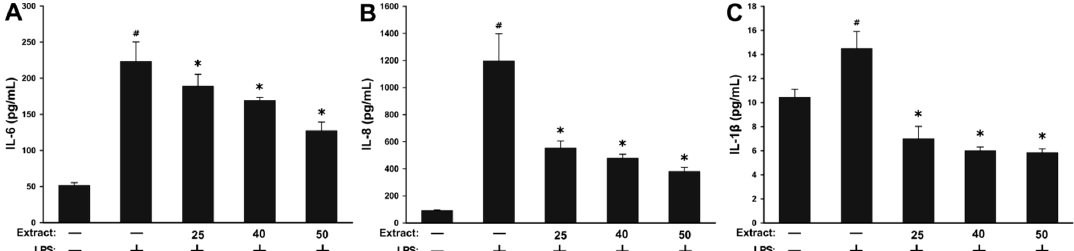
Figure 4. The extracellular release of pro-inflammatory cytokines interleukin-6 (IL-6) ( A ), interleukin-8 (IL-8) ( B ) and interleukin-1 β (IL-1 β ) ( C ) was analyzed in cell-free supernatants by ELISA at 24 h post-exposure to three concentrations of the walnut septum extract (WSE) in combination with 100 ng/mL LPS (lipopolysaccharides). The values are expressed as mean ± standard deviation (SD) of four biological replicates. The asterisk (*) indicates significant differences compared to the positive control (100 ng/mL LPS), while (#) indicates a significant difference of the positive control compared to the negative control (ANOVA + Tukey; p < 0.05).